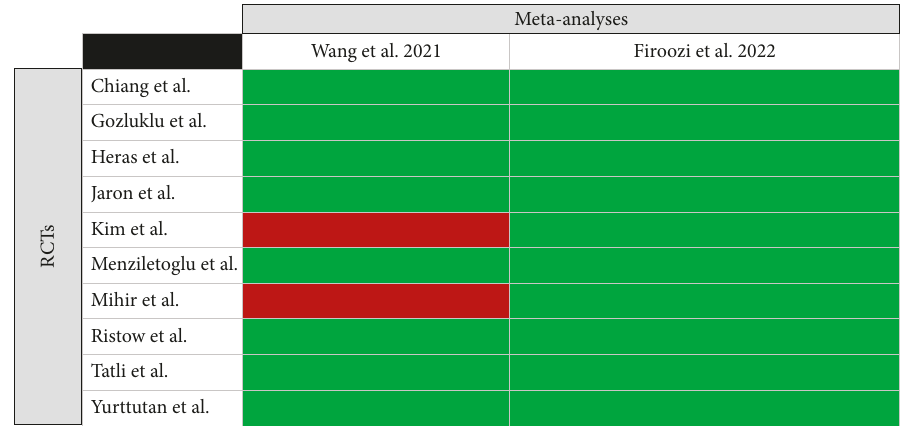
Figure 8: Citation matrix of meta-analyses evaluating the effectiveness of Kinesio taping in reducing pain after third molar surgery (Green � included and Red � not